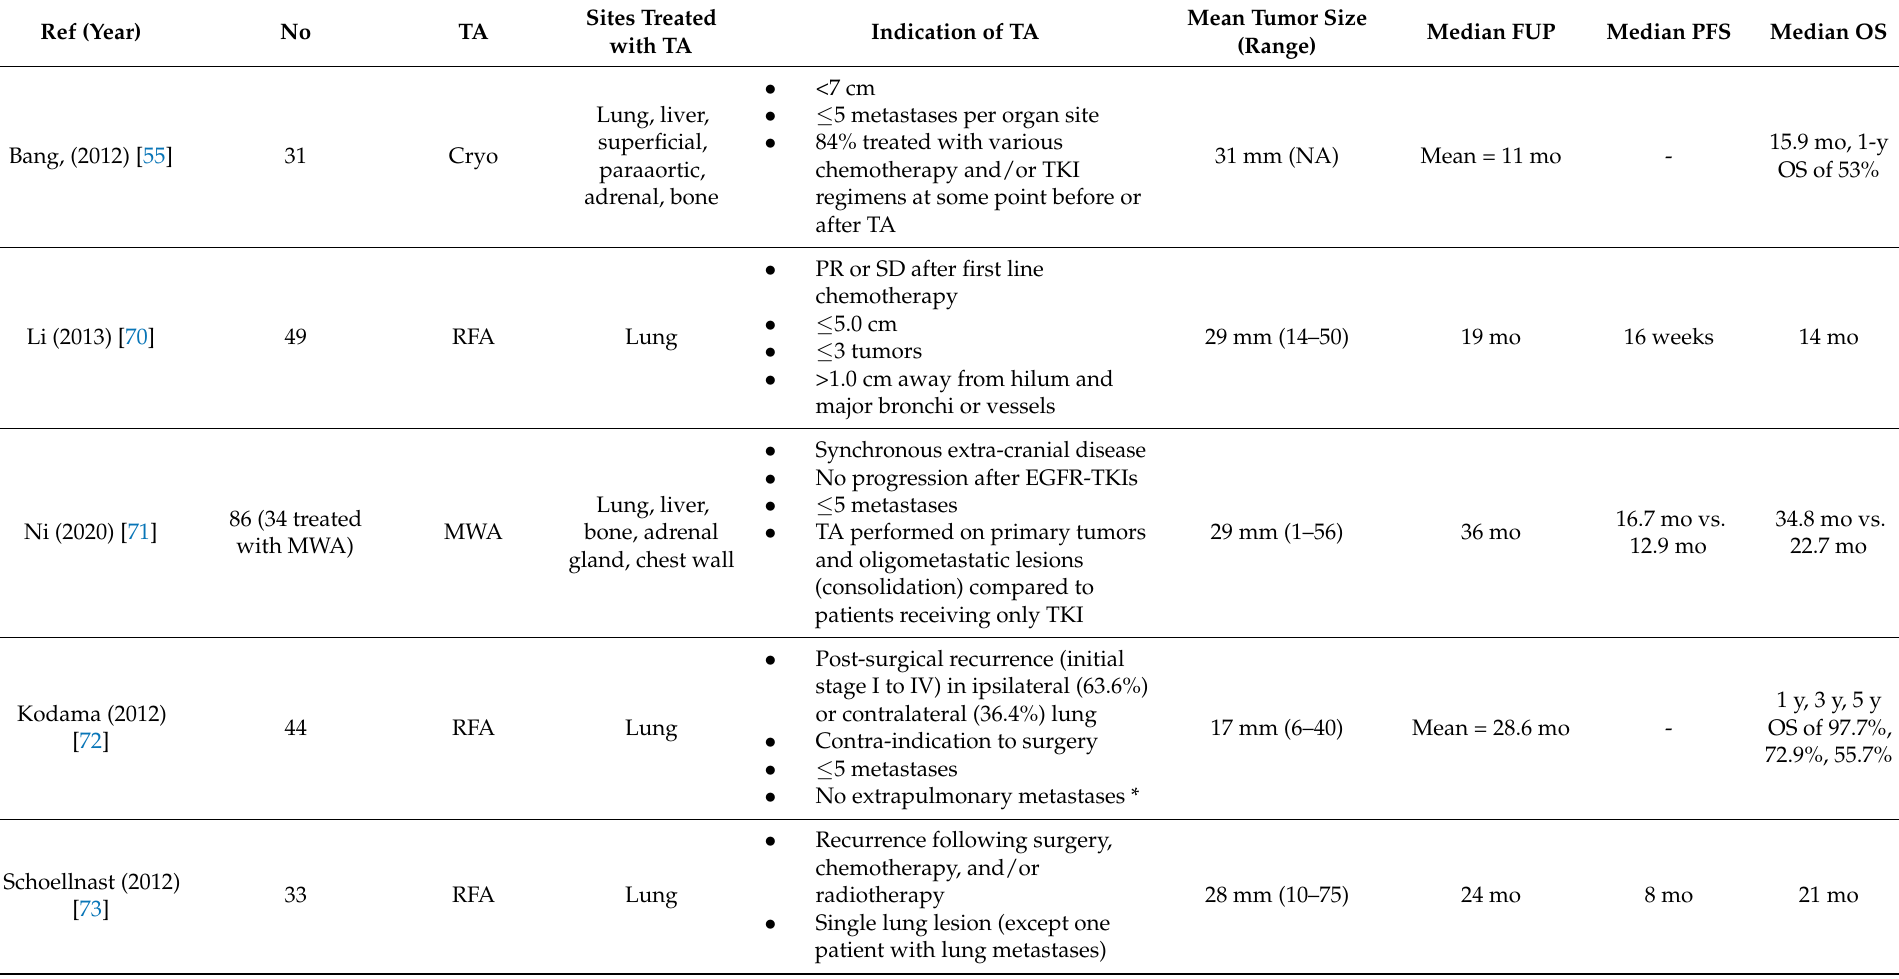
Table 2. Selected retrospective studies evaluating thermal ablation for oligometastatic NSCLC